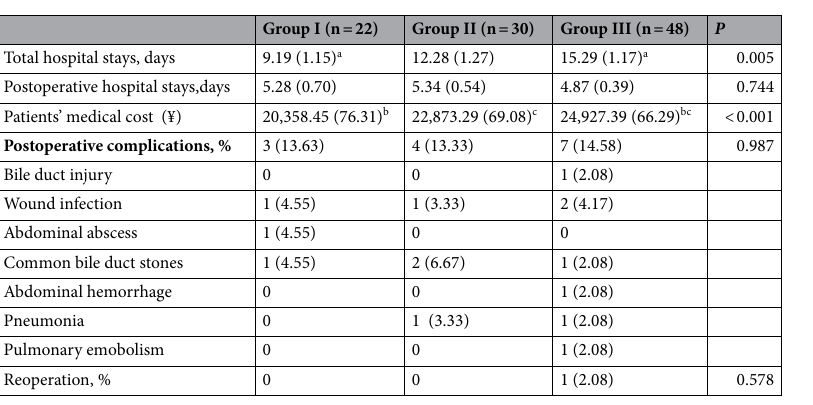
Table 4. Comparison of postoperative outcomes. Values were presented as mean ± SEM or n (%). a P : 0.005; b,c p <